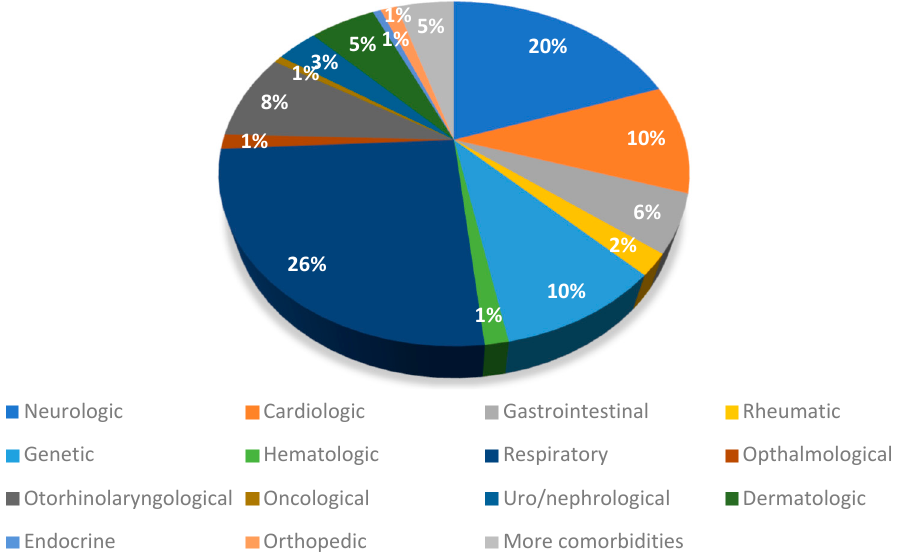
Figure 1. Comorbidities of the children in our cohort study.